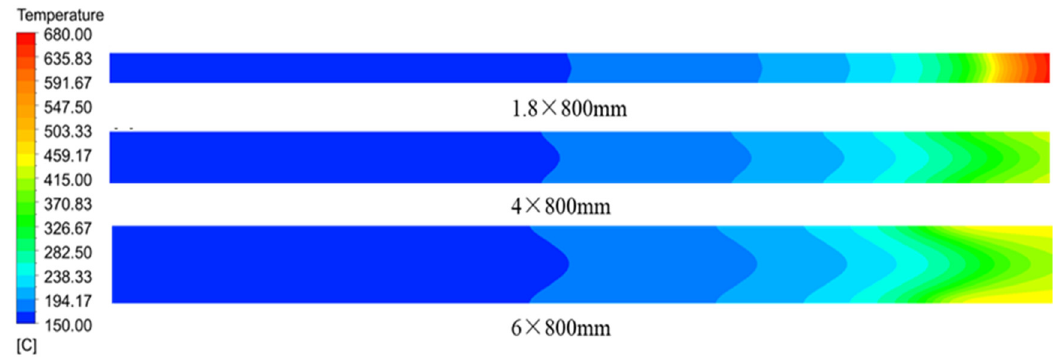
Figure 7. Temperature distribution cloud diagram of the axial section of the microreactor at different tube diameters under adiabatic conditions.